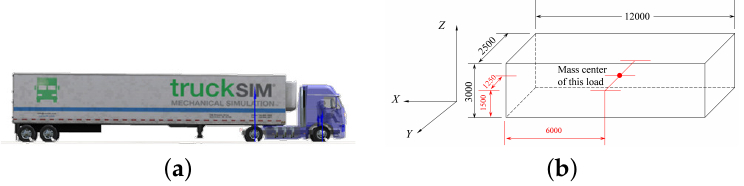
Figure 1. Model of ( a ) four-axle FL box tractor-trailer and ( b ) box payloadFL. Table 1. Four axle box trailer and trailer vehicle parameters.